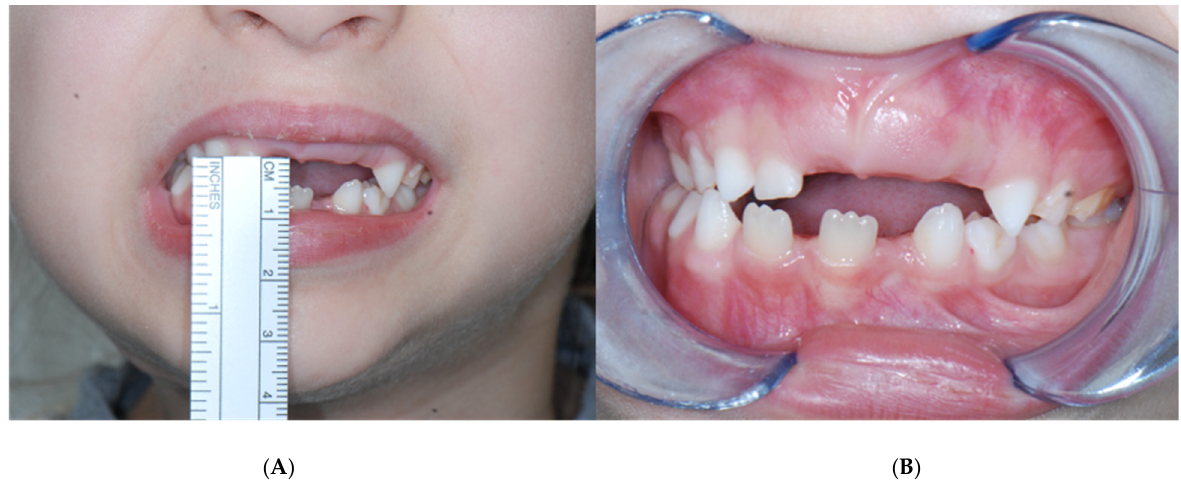
Figure 4. ( A ) MMO of less than 10 mm, ( B ) evidence of a recurrence of